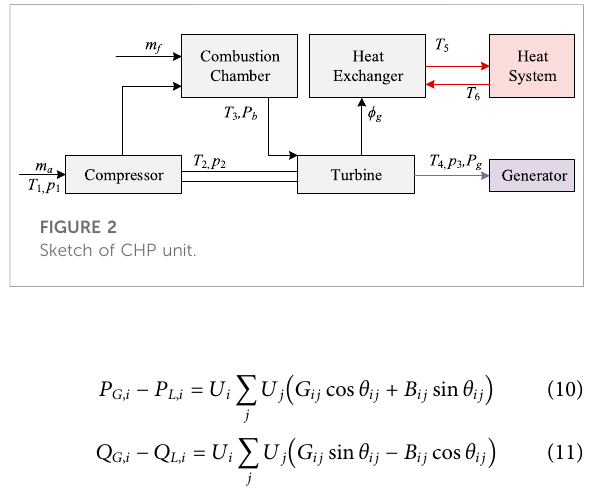
FIGURE 2 Sketch of CHP